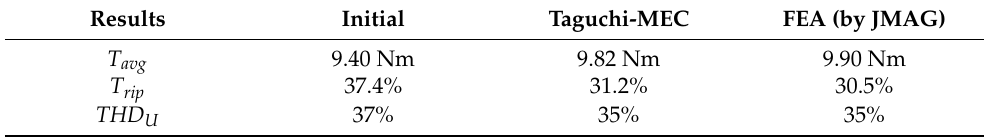
Table 6. Comparison of the Optimization Results Between Taguchi-MEC and FEA.